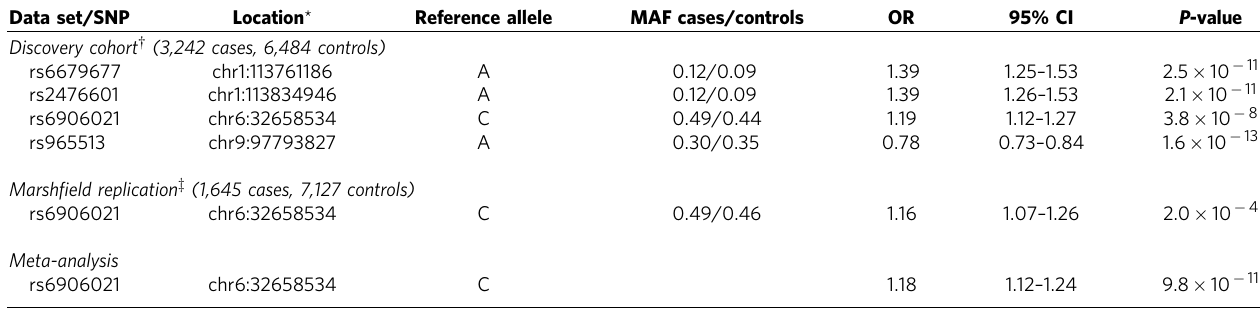
*Coordinates are for genome assembly GRCh38.p2. w From an additive logistic regression model, adjusting for age, gender and three principal components. z From an additive logistic regression model, adjusting for age and gender.